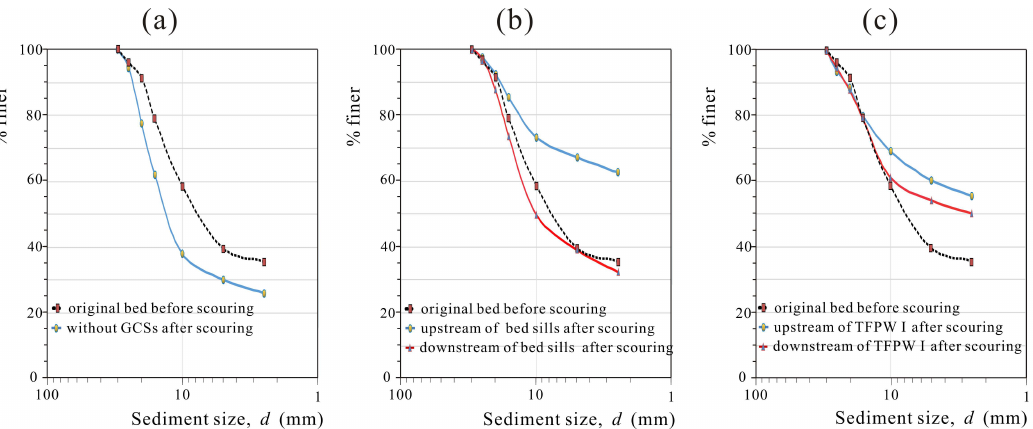
Figure 6. Particle size distribution curves in the upstream and downstream reaches under different structural conditions, respectively: ( a ) without any GCSs; ( b ) under the protection of bed sills; and ( c ) under the protection of TFPW